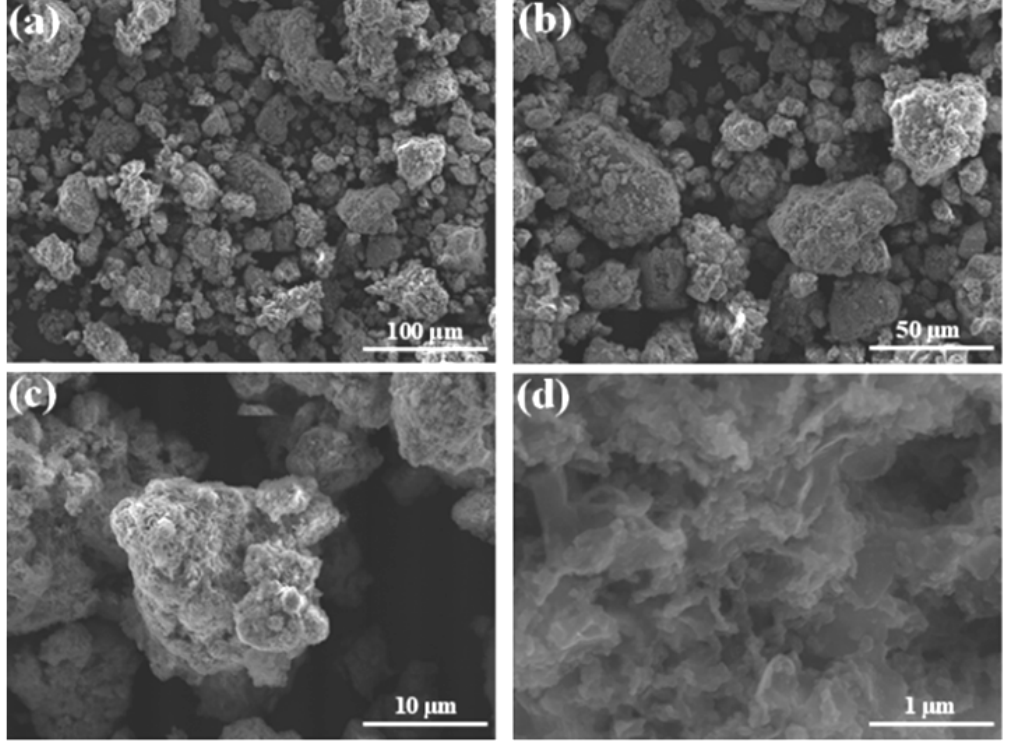
Figure 6. SEM micrographs of MA Mn-Al-Co after RB5 degradation at different magnifications. Scale bars: ( a ) 100 µm, ( b ) 500 µm, ( c ) 10 µm and ( d ) 1 µm.